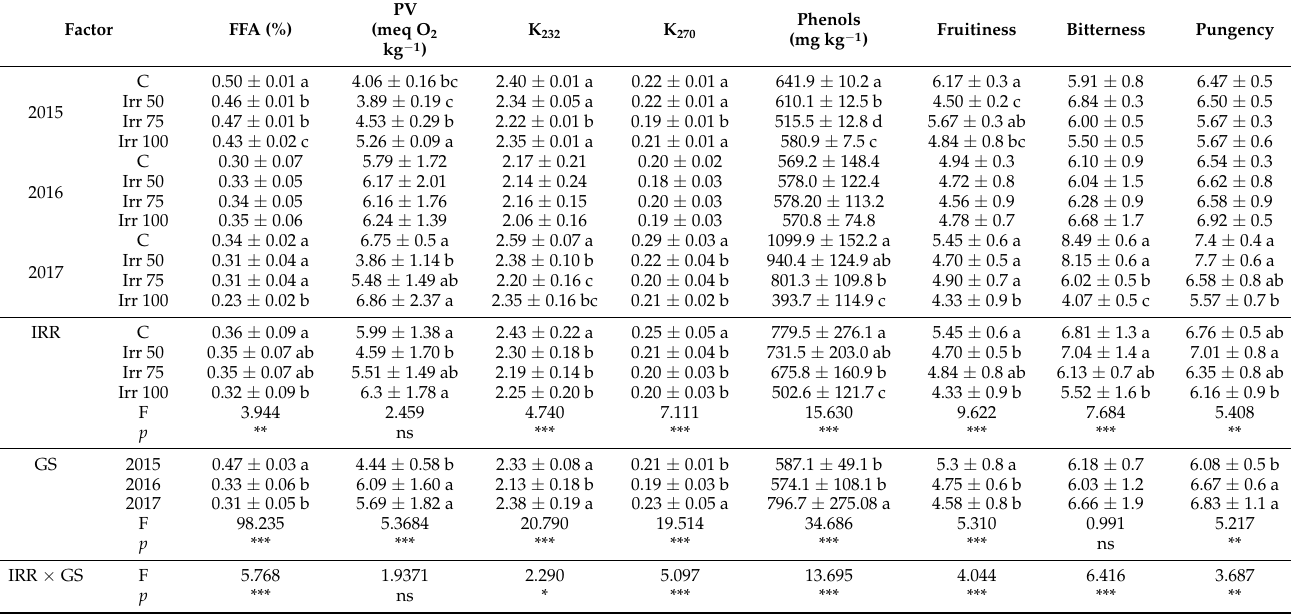
Table 5. Effect of different irrigation levels on quality paremetrs, phenols and sensory properties in virgin olive oils in three experimental